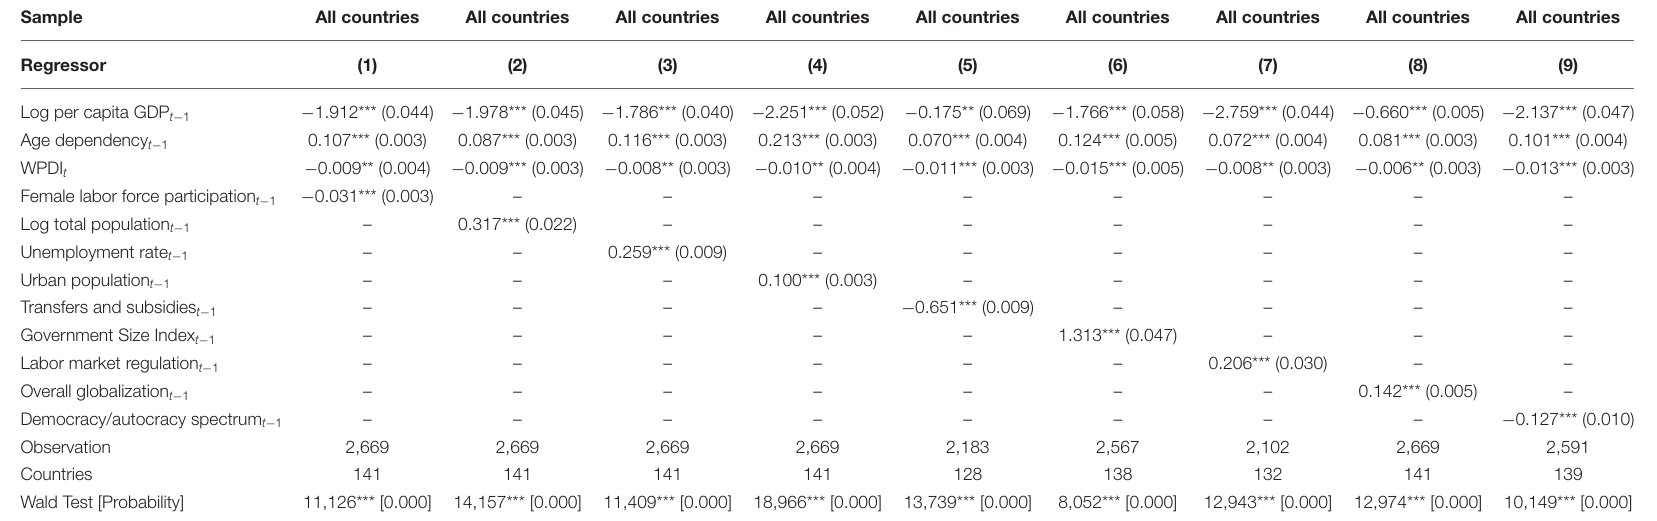
TABLE 4 | Feasible General Least Squares (FGLS) estimations (all countries) (1996–2020).